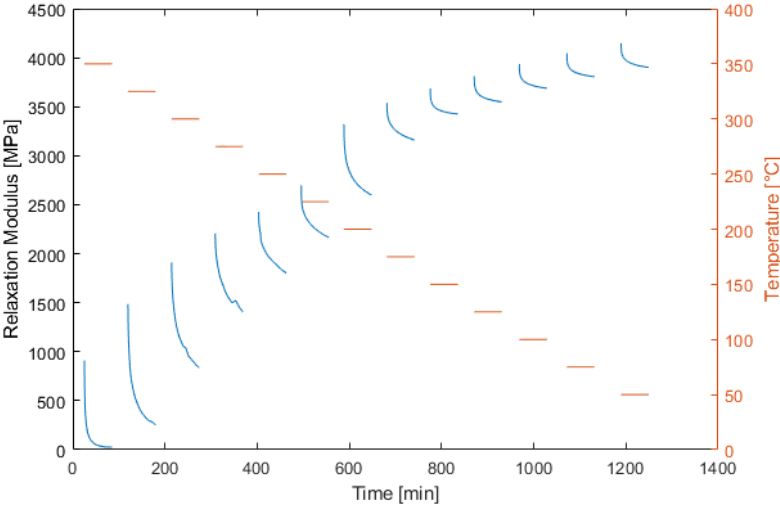
Figure 5. Measured relaxation modulus for a temperature sweep from 350 to 20 °C.